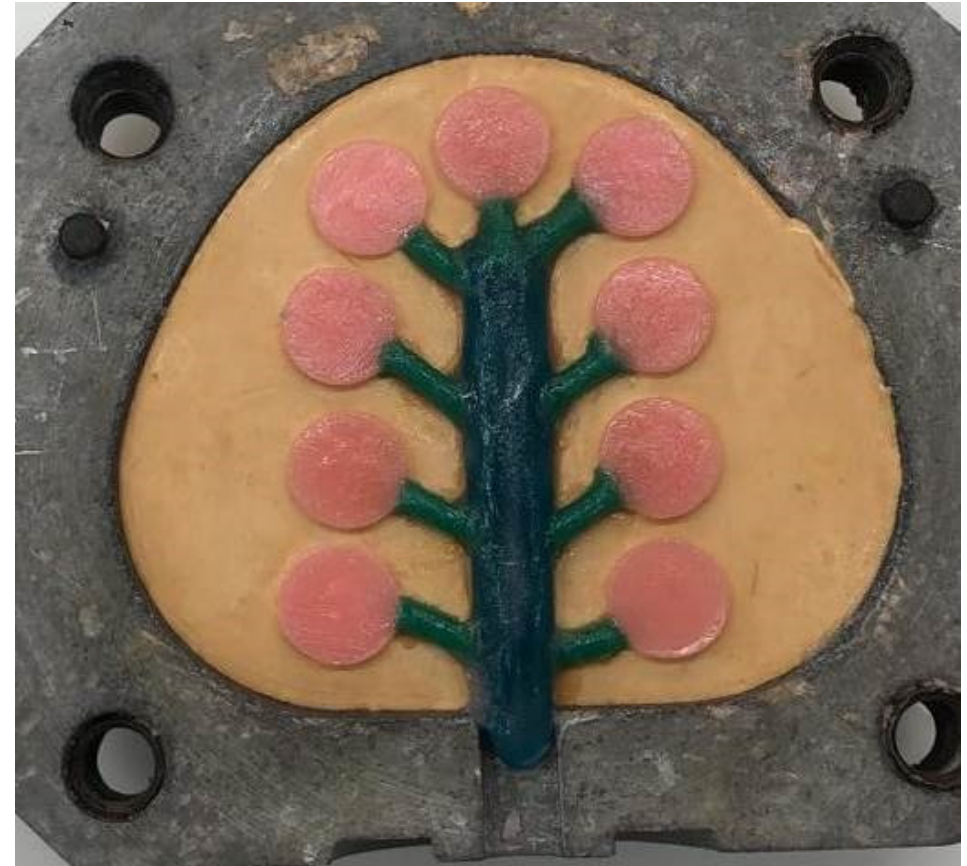
Figure 3. Wax patterns invested for injection molding technique.